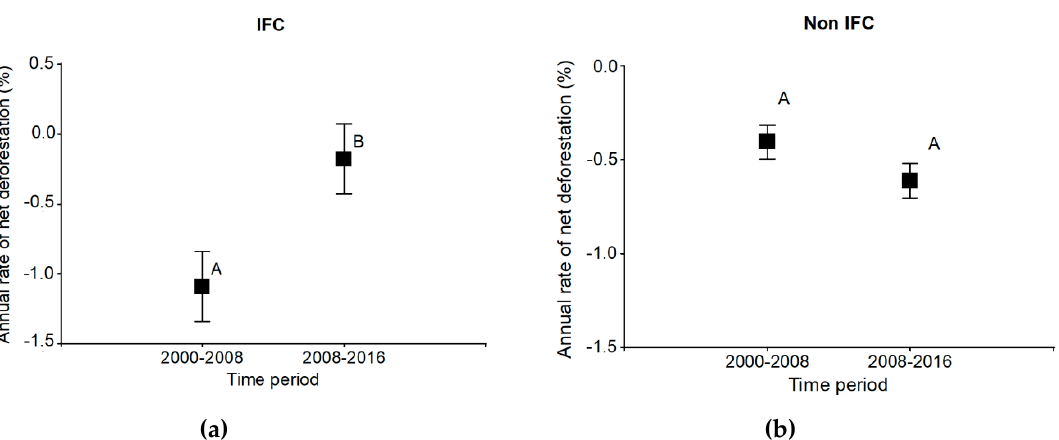
Figure 6. Analysis of variance of annual net deforestation rate (%) at the parish level. ( a ) IFC landscapes ( p = 0.04). ( b ) Non-IFC landscapes ( p = 0.15). Different letters indicate significant differences from each other ( p ≤ 0.05).